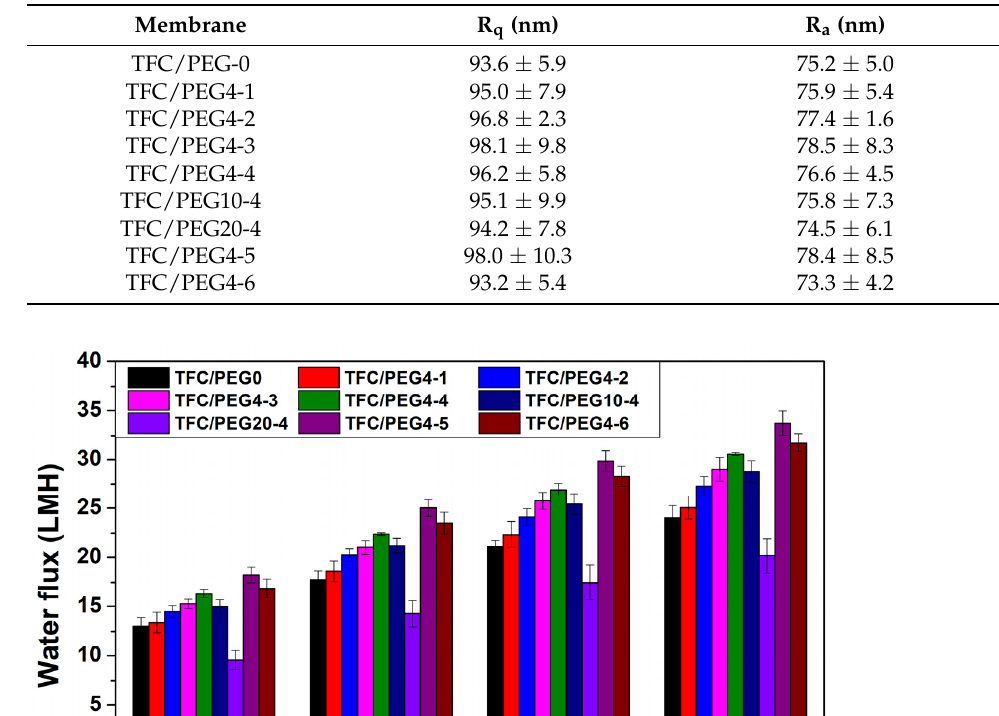
Table 5. Intrinsic properties of PSU/PEG supported TFC-FO membranes.